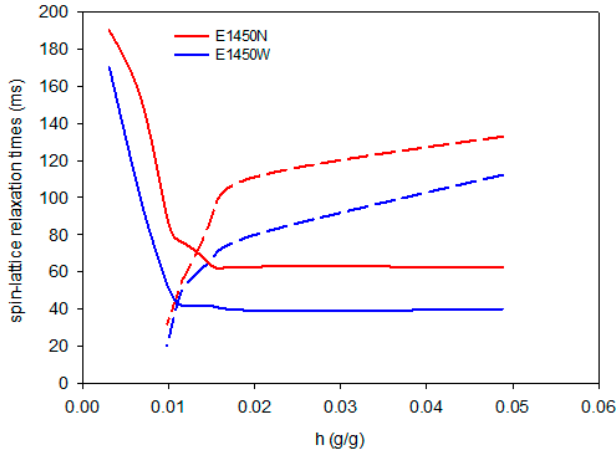
Figure 5. Changes in the short T 11 (solid) and long T 12 (dashed) components of spin-lattice relaxation times during hydration of OSA starch aerogels.